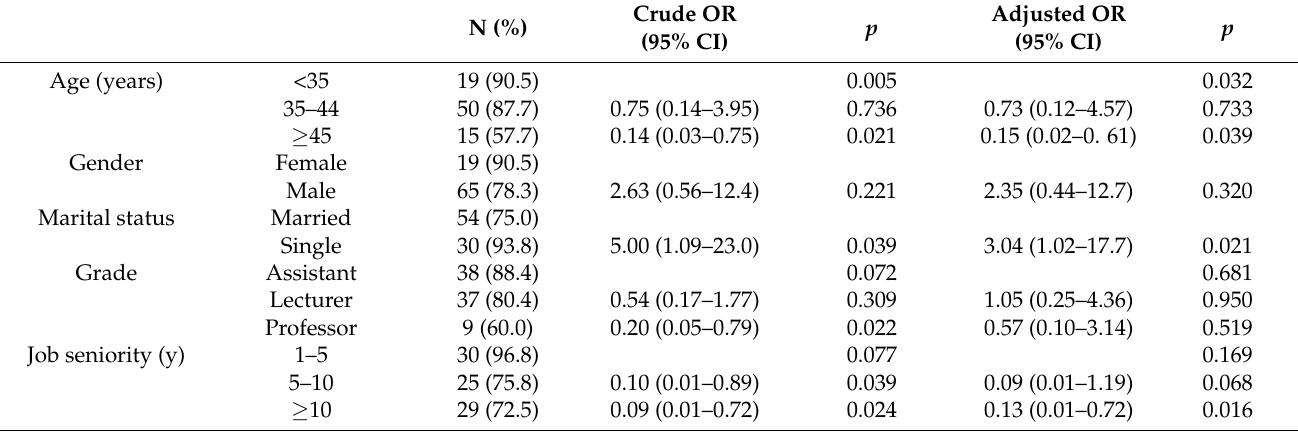
Table 5. Association of MSDs during previous 12 months with socio-demographic, socio-professional and anthropometric